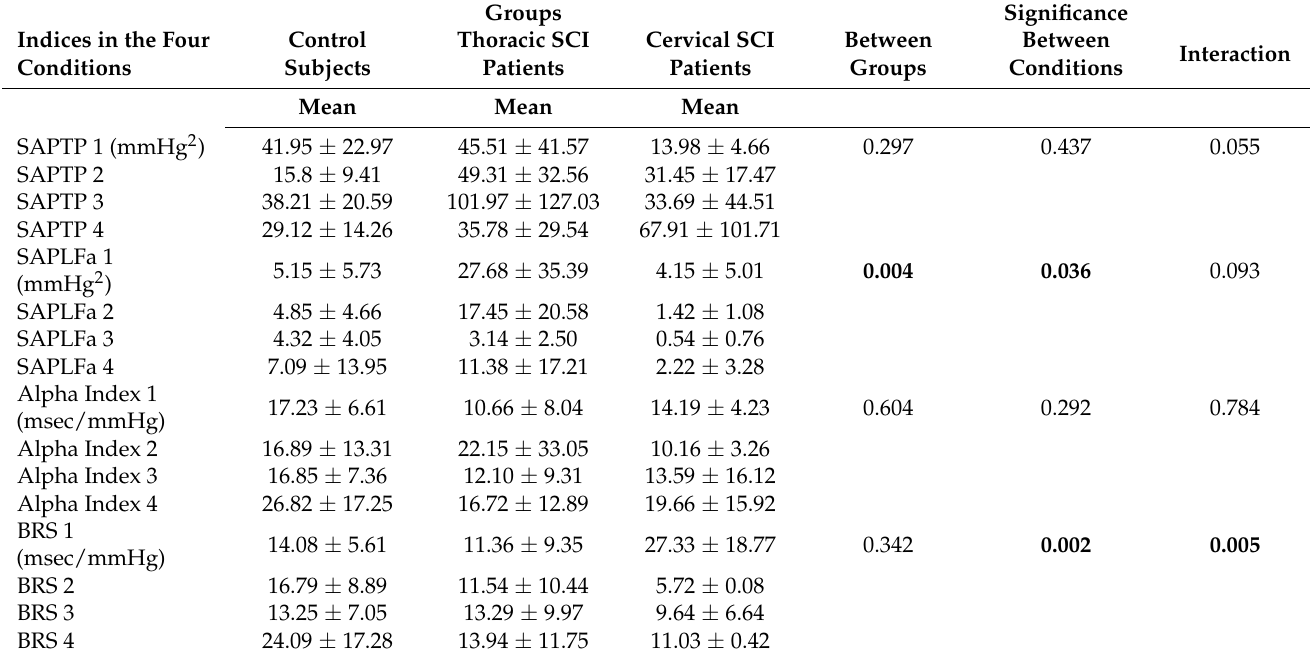
Table 1. Cont. Groups